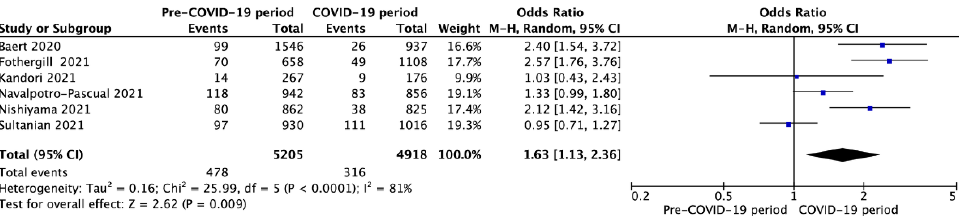
Figure 7. Forest plot of survival to hospital discharge with CPC 1 or 2 in pre- vs. intra-COVID-19 periods. The center of each square represents the weighted odds ratios for individual trials, and the corresponding horizontal line stands for a 95% confidence interval. The diamonds represent pooled results. Legend: CI = confidence interval; OD = odds ratio.